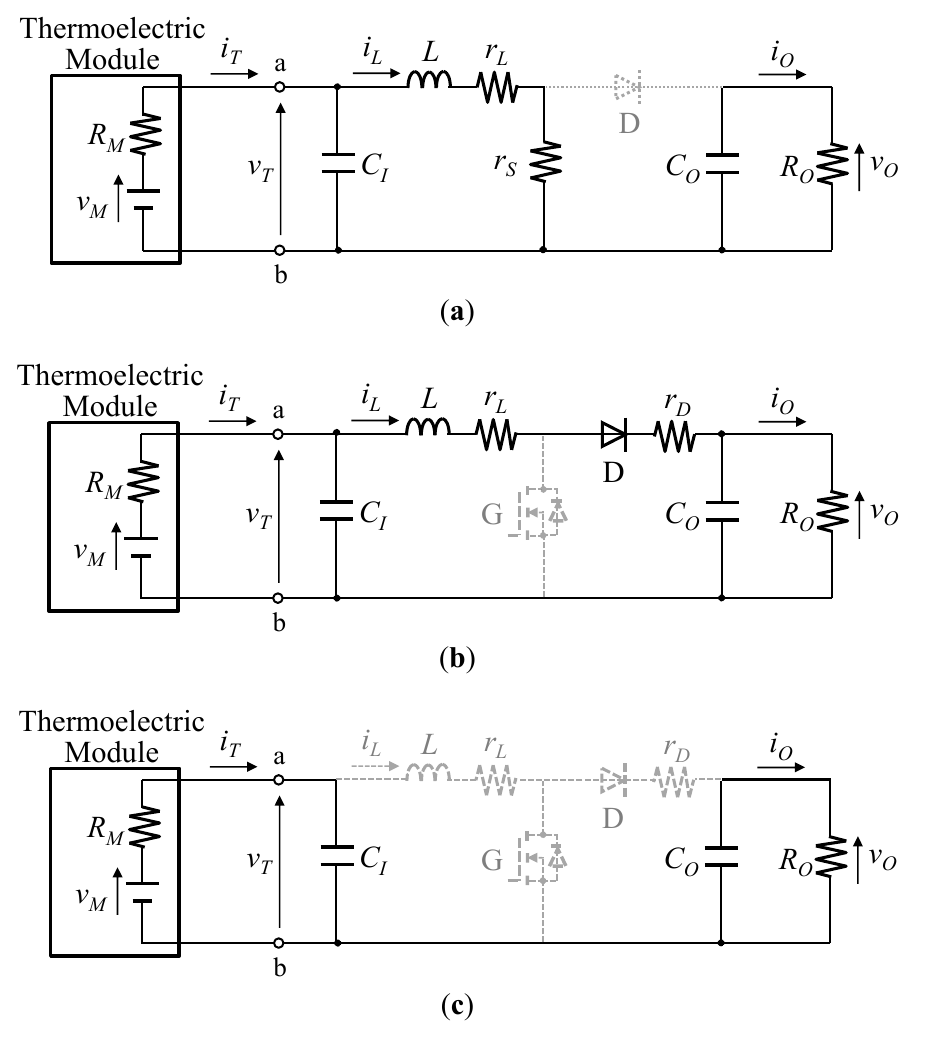
Figure 5. Equivalent circuits of the thermoelectric power generation system. ( a ) MODE 1; ( b ) MODE 2; ( c ) MODE